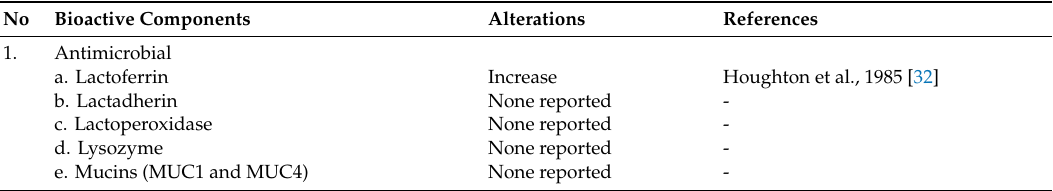
Table 1. Alteration of immunological properties in human milk of obese